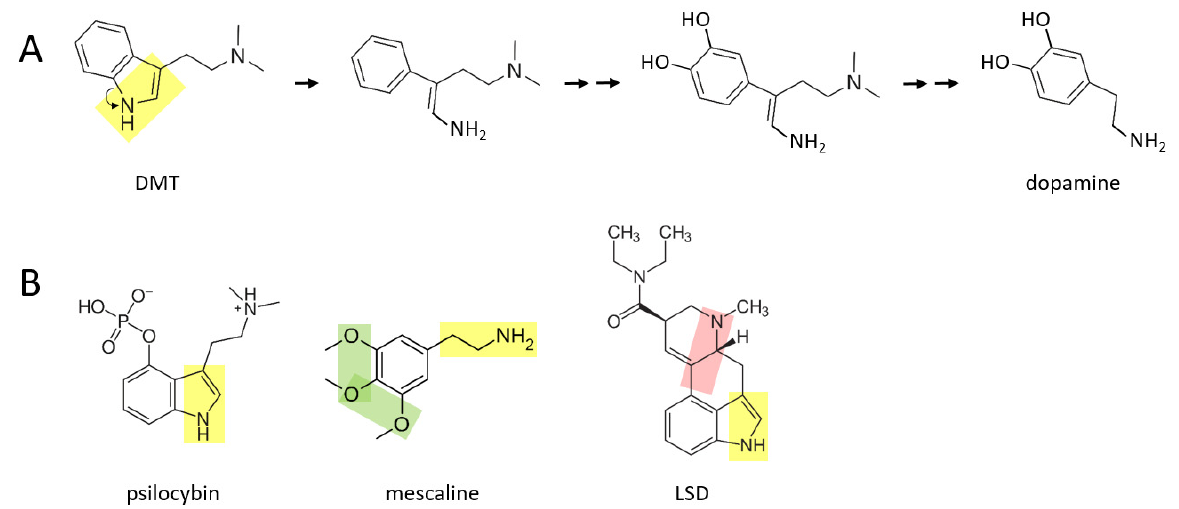
Figure 3. Several psychedelics may be transformed to catecholamines in vivo. ( A ) DMT may be converted to dopamine through a series of proposed chemical reactions. Double arrows indicate two or more reactions. ( B ) Psilocybin and mescaline possess the yellow or green moieties that may allow transformation to catecholamines. LSD is a more complex molecule, and it is suggested here that conversion to catecholamines could occur, in part, either through the yellow or pink moiety.